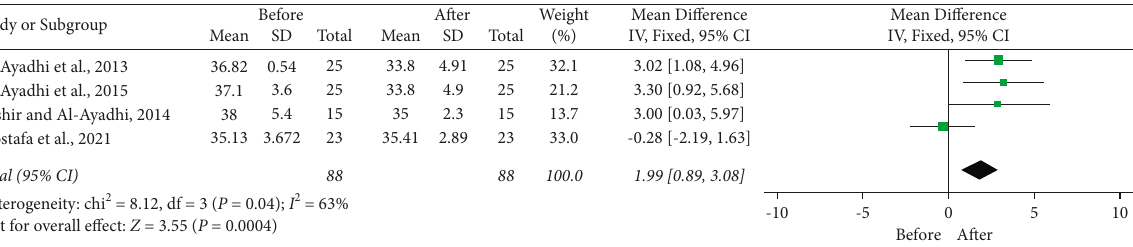
Weight Mean Difference TotalBefore TotalAfter Mean SD (%) IV, Fixed, 95% CI